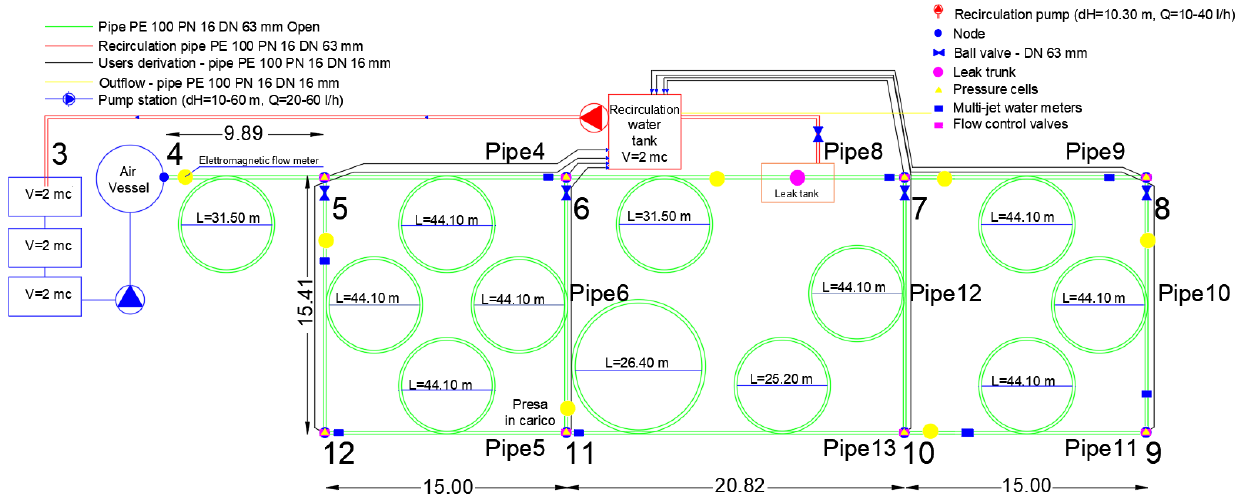
Figure 1. The layout of the experimental water distribution network.